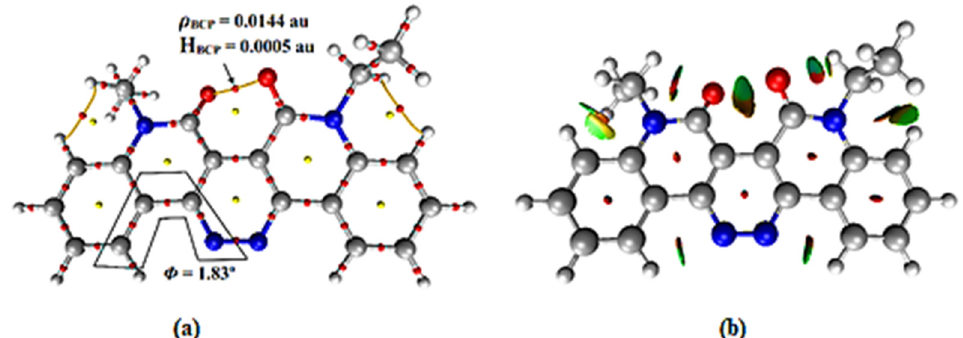
Figure 4. ( a ) Quantum theory of atoms in molecules (QTAIM) and ( b ) 3D noncovalent interaction (NCI) isosurfaces for compound 3a . The isosurfaces were generated with a reduced density gradient value of 0.50 au and colored from blue to red according to sign ( λ 2 ), ρ ranging from − 0.035 (blue) to 0.020 (red) au.